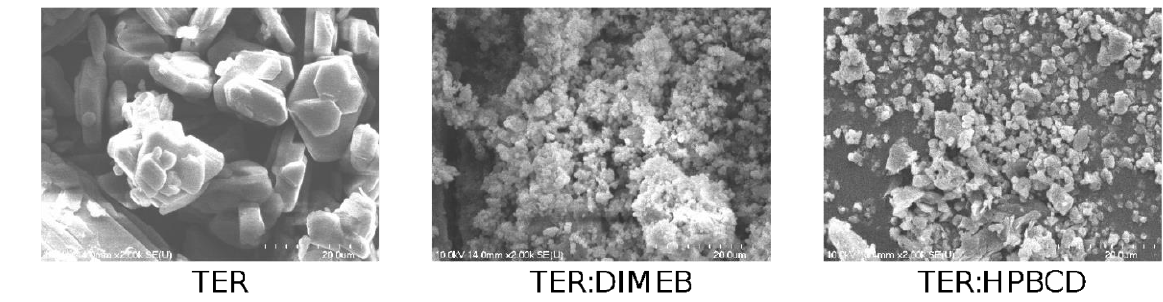
Figure 11. SEM images of TER and co-ground products at 2.00 k magnitude.